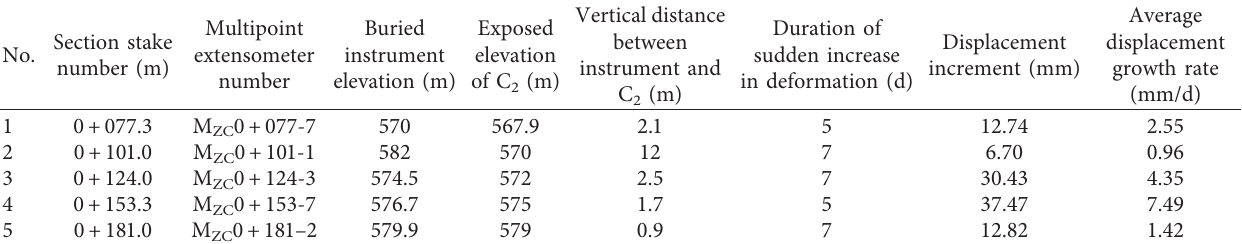
Table 1: Statistics of the sudden increase in downstream sidewall deformation in the main powerhouse measured by multipoint ex- tensometers near C 2